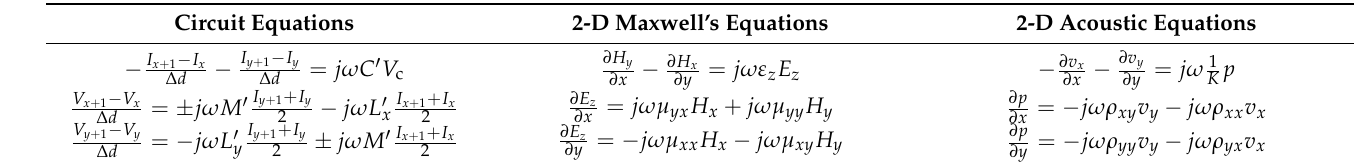
Table 2. Correspondences of voltages, currents, electric fields, magnetic fields, scalar pressures, and fluid velocities in the equations of Table